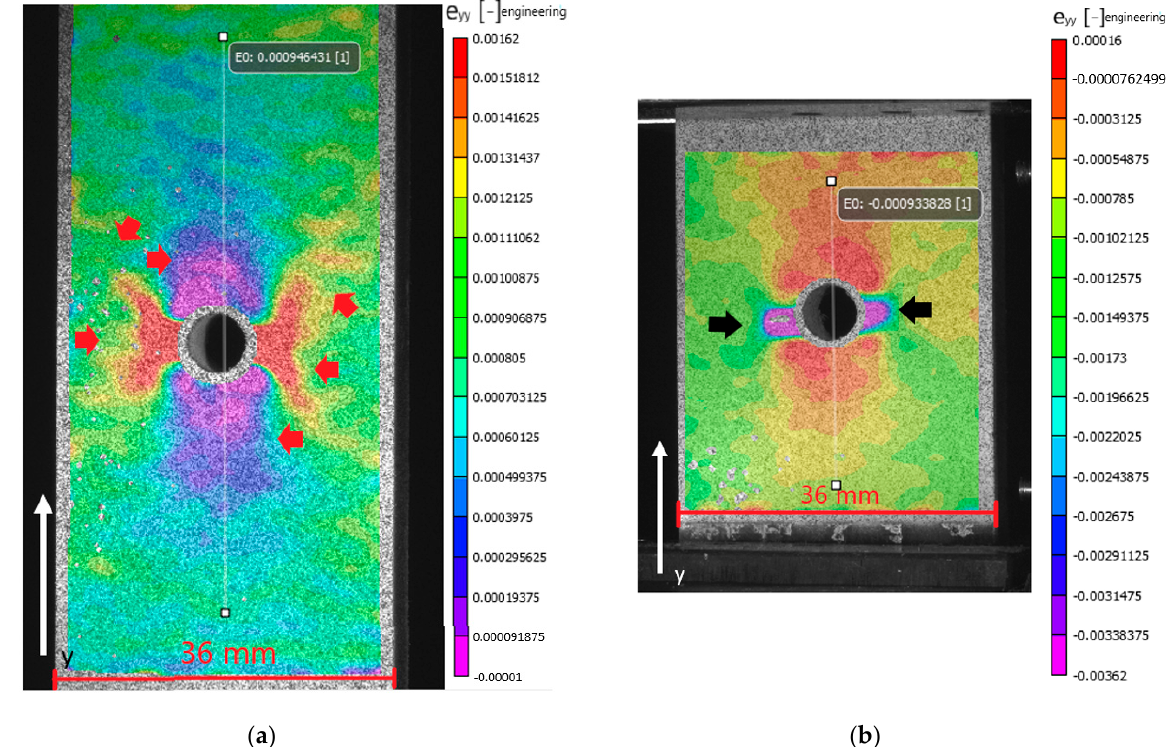
Figure 14. Permanent strain developed after unloading specimen ( a ) LUR-OHT and ( b ) LUR-OHC for the laminate with layup [+45/0/ − 45/90] 3s after the highest loading cycle before failure.